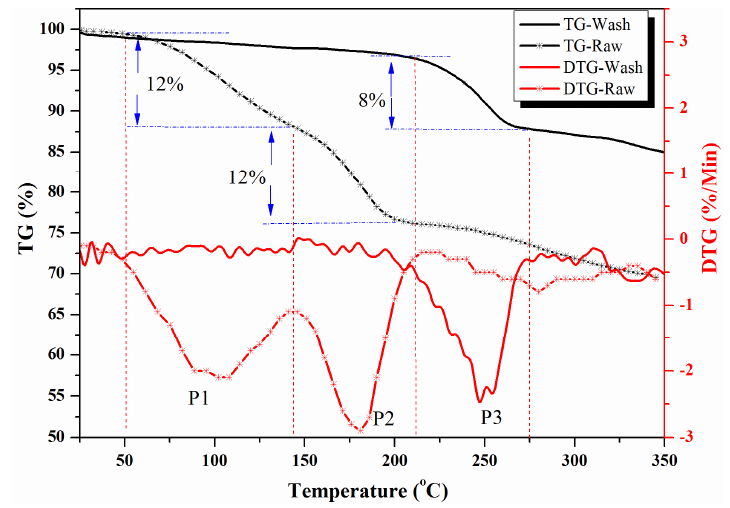
Figure 11. TG-DTG curves of the raw ASS and washed ASS.